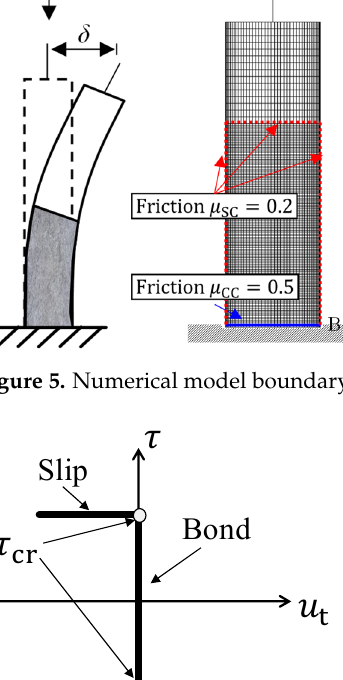
Figure 4. Sectioning of elements in the numerical model: ( a ) Steel tube and concrete; ( b ) Diaphragm; ( c ) Concrete section.